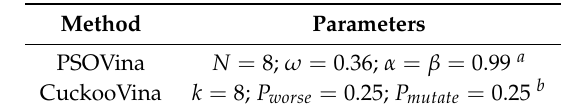
Table 1. Docking parameters used in experiments: For PSOVina, number of particles N , inertia weight ω , cognitive weight α , social weight β . For CuckooVina, number of host nests k , switching parameter P worse , mutate probability P mutate